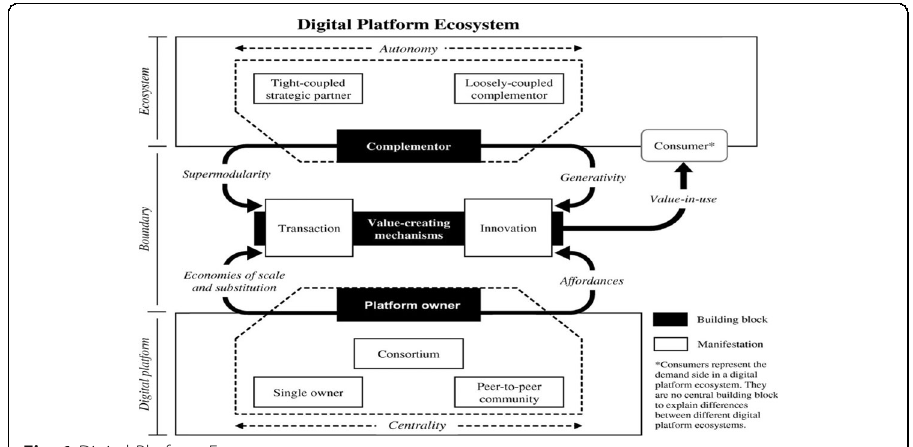
Fig. 1 Digital Platform